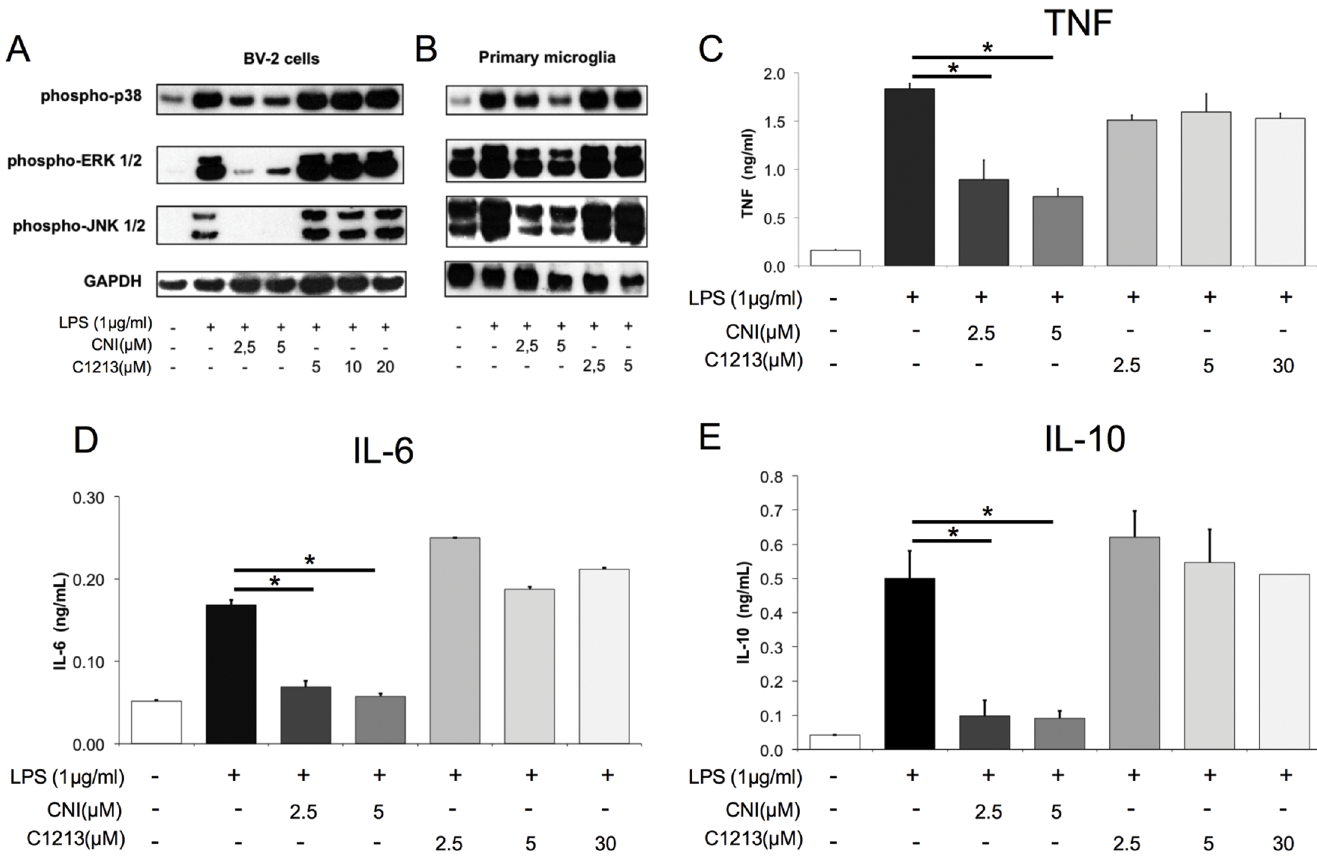
Figure 3. C1213 does not inhibit phosphorylation of MAP-kinases or cytokine secretion in primary microglia. (A-B) MAP-kinase western blot: (A) BV-2 cells or (B) primary microglia were treated with the indicated concentrations of CNI-1493 or C1213 1 h prior to LPS treat- ment (1 μ g/mL). Cells were lysed 15 min after LPS treatment and western blot analysis against phospho-p38, phospho-ERK 1/2, phos- pho-JNK 1/2 and GAPDH was performed. (C-D) Cytokine ELISA: Primary microglia were treated with CNI-1493 (2.5 and 5 μ M) or C1213 (2.5, 5 and 30 μ M) 1 h prior to LPS treatment (1 μ g/ml). The following cytokine concentrations in the media were determined via ELISA analysis: (C) TNF 1 h, (D) IL-6 2 h, and (E) IL-10 7 h after LPS treatment. *